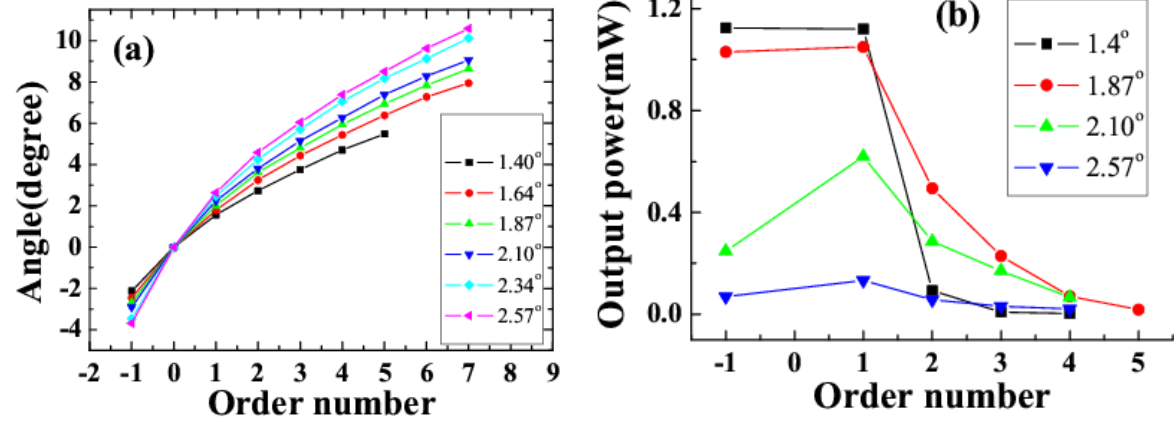
Figure 9. (a) Dependence of the angles between the generated sidebands and beam2 ( with 0 order number) on the order number of the sidebands when the crossing angle between the two input beams was 1.40º, 1.64º, 1.87º, 2.10º, 2.34º, and 2.57º. (b) Dependence of the output power on the order number when the crossing angle between the two input beams was 1.40º, 1.87º, 2.10º, or 2.57º. Order number-1 refers to S1, 1 refers to AS1, and so on